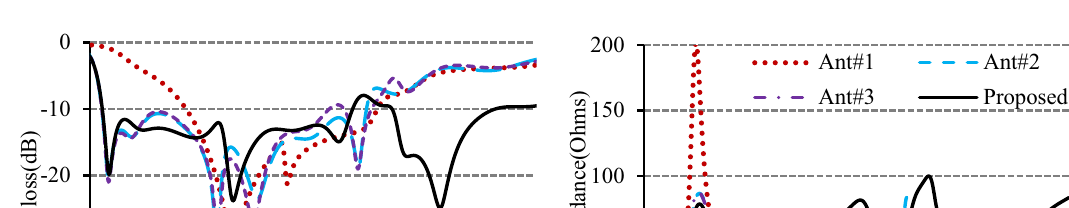
Figure 3. Design evolution of the proposed antenna.